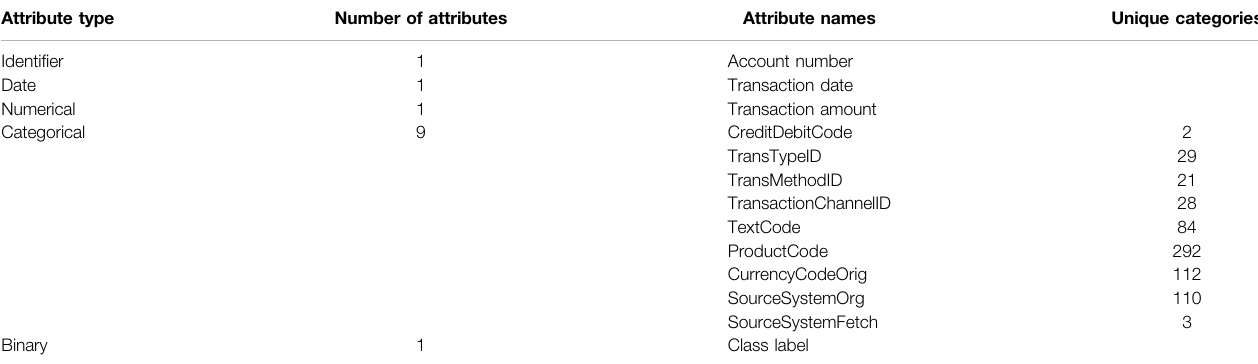
TABLE 1 | Dataset attributes prior to